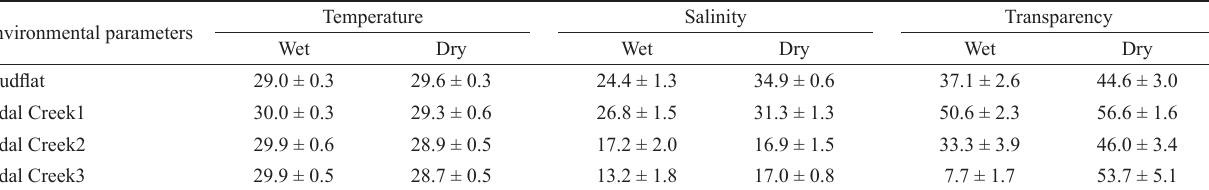
Table 1. Mean variations in the environmental parameters (±SE) for the study period in rio Mamanguape estuary, northeastern Brazil.